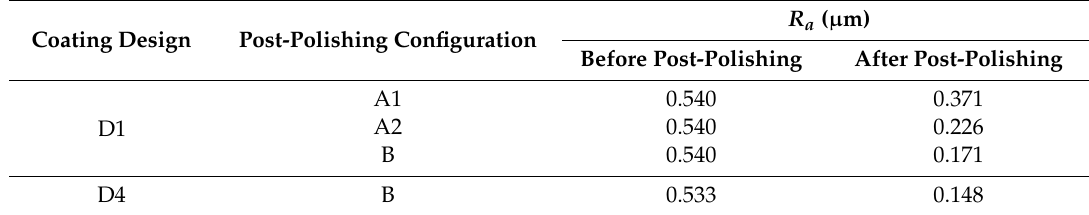
Table 7. Polish post-processing results.